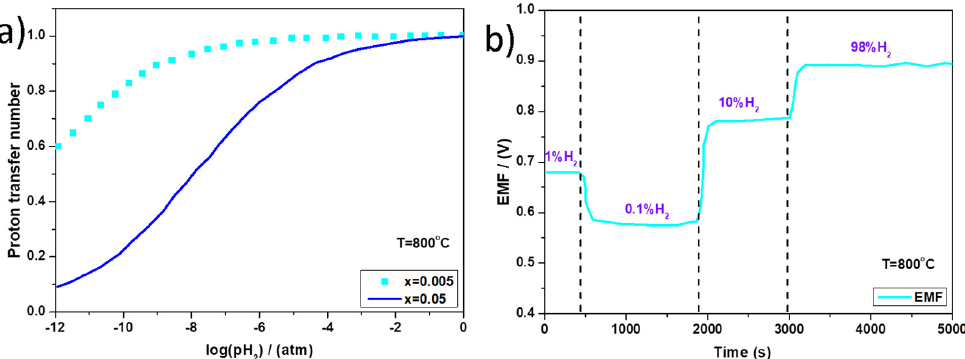
Figure 2. ( a ) Proton transfer number change with alteration of the atmosphere, for CaZr 1-x Mn x O 3- δ , the dashed line corresponds to x = 0.005, while the solid line corresponds to x = 0.05. ( b ) EMF variation and time response to the changes in the gas mixture, for the galvanic cell using CaZr 0.95 Mn 0.05 O 3- δ as electrolyte. (Data reproduced from [25].)